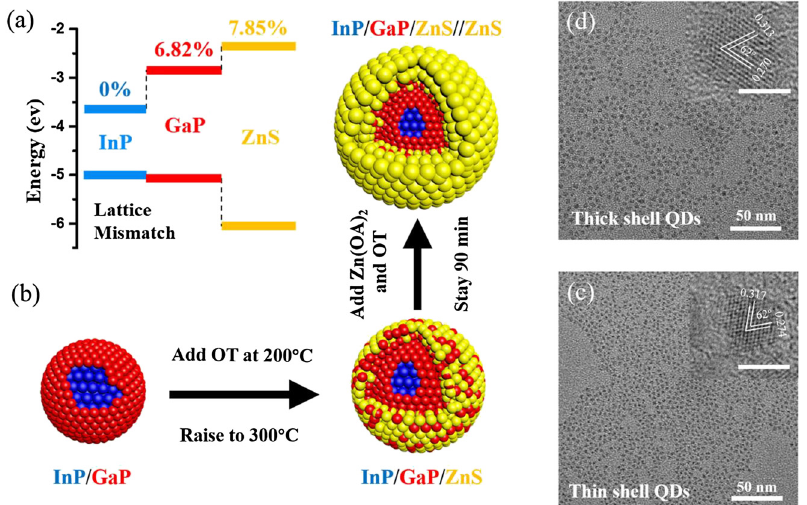
Figure 14: (a) Energy levels of bulk InP, GaP, and ZnS, and the lattice mismatch between them. (b) The synthesis process of thick- shell InP/GaP/ZnS//ZnS QDs (c, d) TEM images of two types of InP-based QDs: (c) Thin shell InP/GaP/ZnS QDs and (d) thick shell InP/GaP/ZnS QDs. The HRTEM images are shown in the insets with a scale bar of